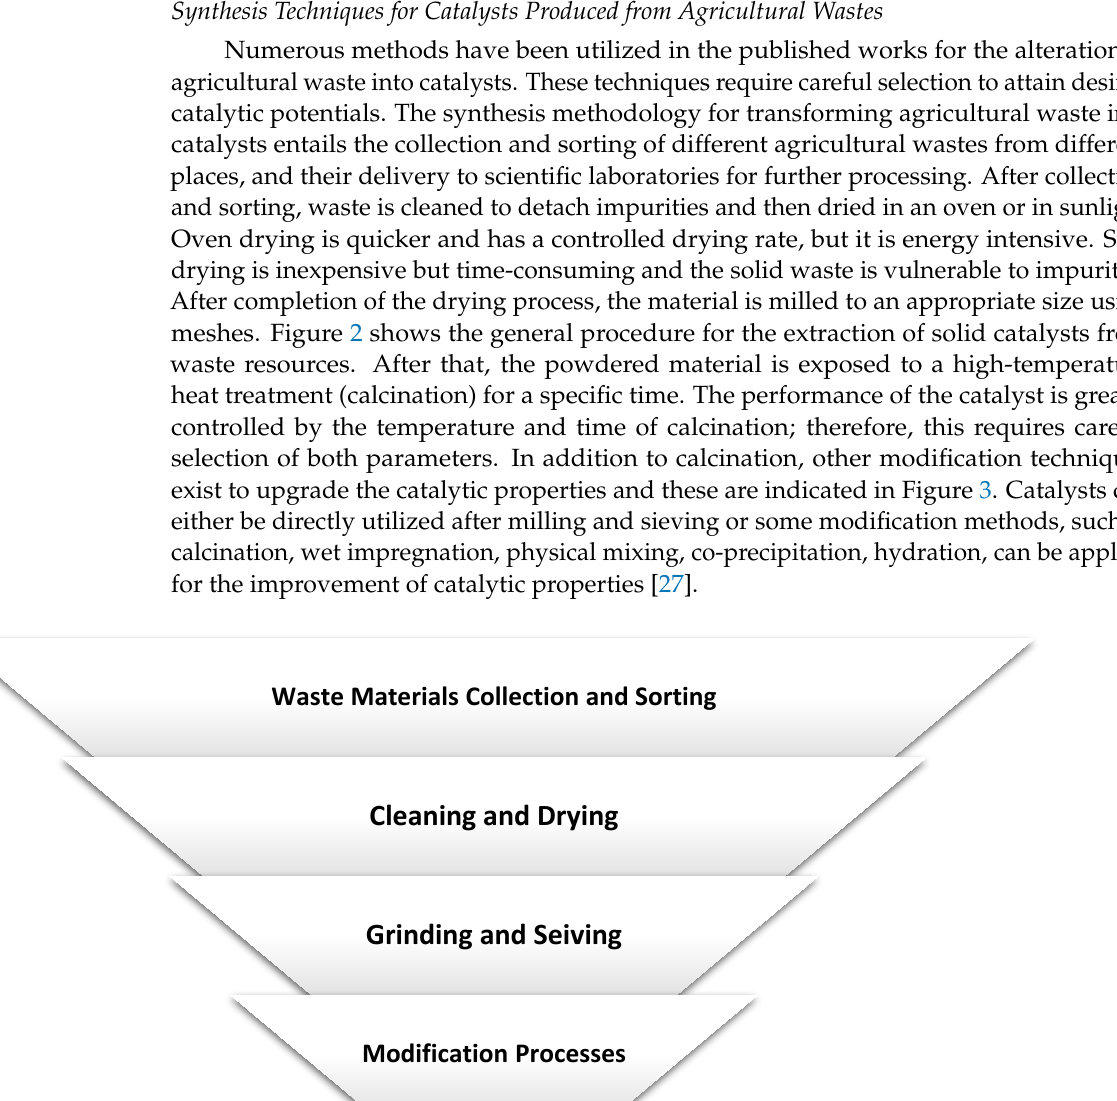
Figure 3. Catalyst synthesis methods for biodiesel production using agri-waste